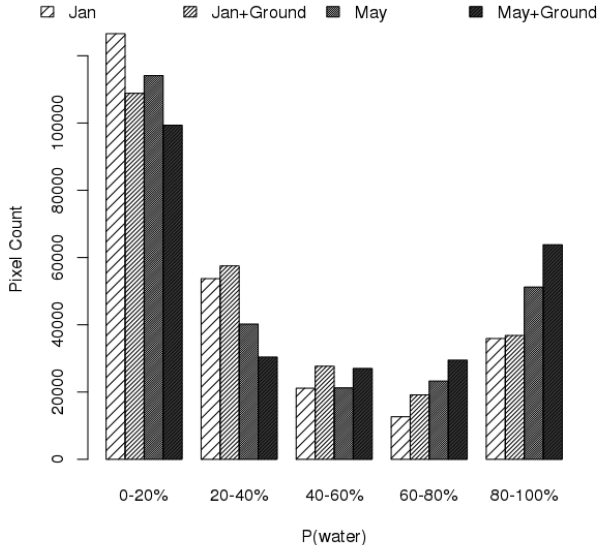
Fig. 7. Number of pixels classified as Figure 7: Number of pixels classified as water.